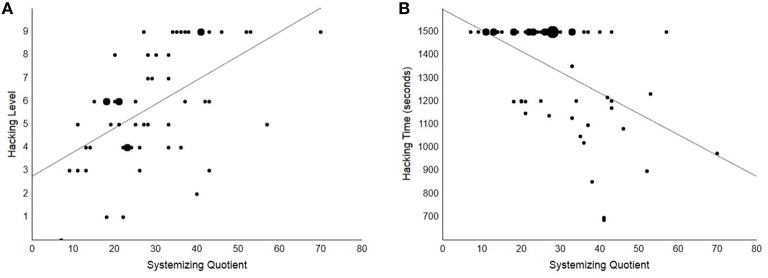
Scatterplots showing the significant correlations between SQ and hacking performance (ps < 0.001). (A) Scatterplot showing a significant positive correlation (ρ = 0.55, p < 0.001) between SQ and hacking level. This correlation cannot be accounted for by expertise or gender bias alone (see main text). Dot size is directly proportional to the number of cases placed at the same coordinates. (B) Scatterplot showing a significant negative correlation (ρ = −0.47, p < 0.001) between SQ and hacking time. This correlation appeared less robust than the correlation between SQ and with hacking level as it was not significant when controlling for the effects of expertise and gender bias (see main text). This may be also due to the majority of participants having used up all the available time to solve the hacking challenge, with considerably reduced variability in the hacking time data compared to the hacking level data.